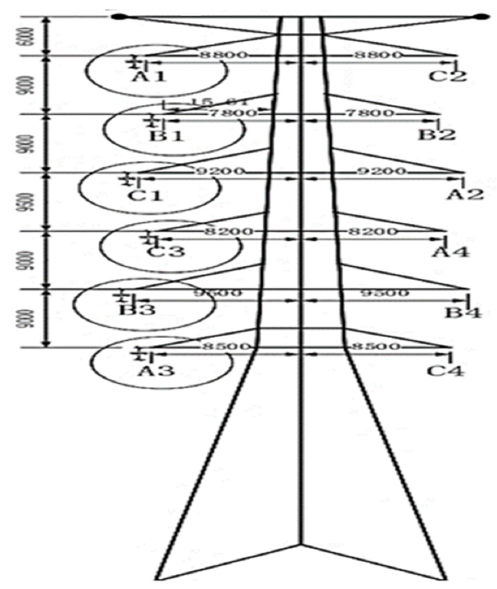
Figure 20. Honeycomb-filled structure [68].